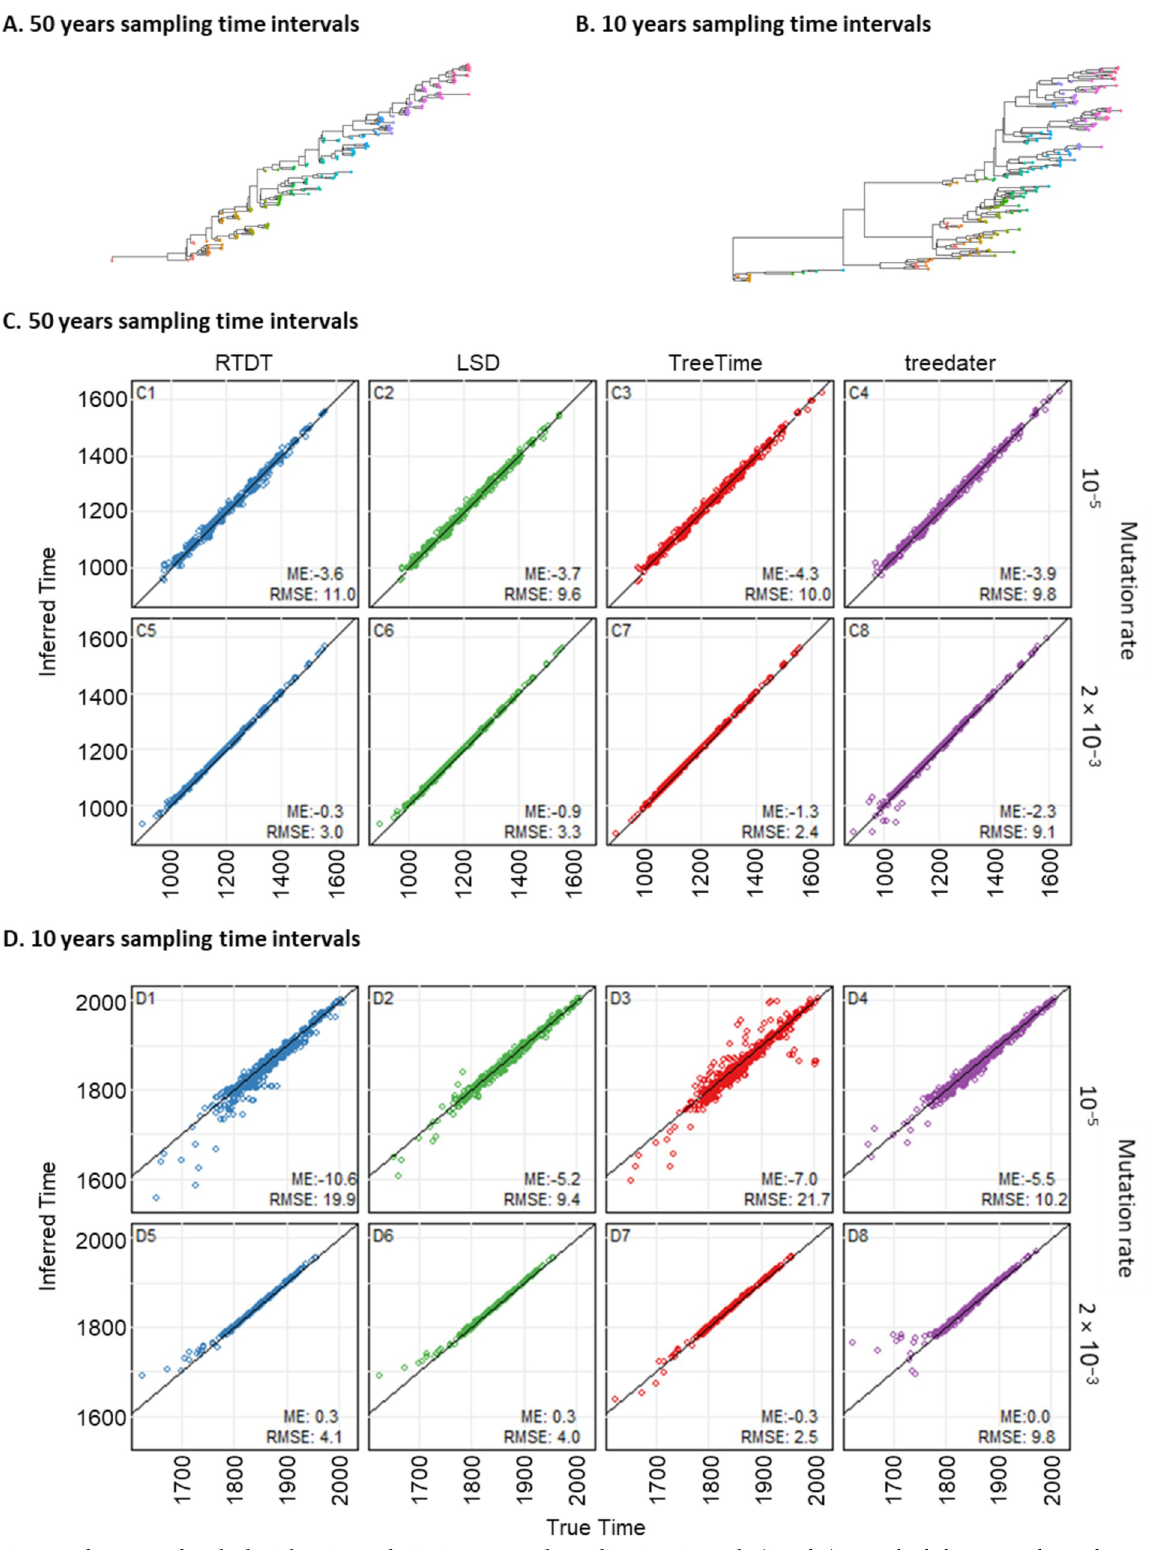
Fig 7. Performance of methods with various substitution rates and sampling time intervals. (A and B) Example phylogenies with sampling time intervals of 50 years (A) and ten years (B). Phylogenies with sampling time intervals of 50 years are Flu-like (A), while those with ten